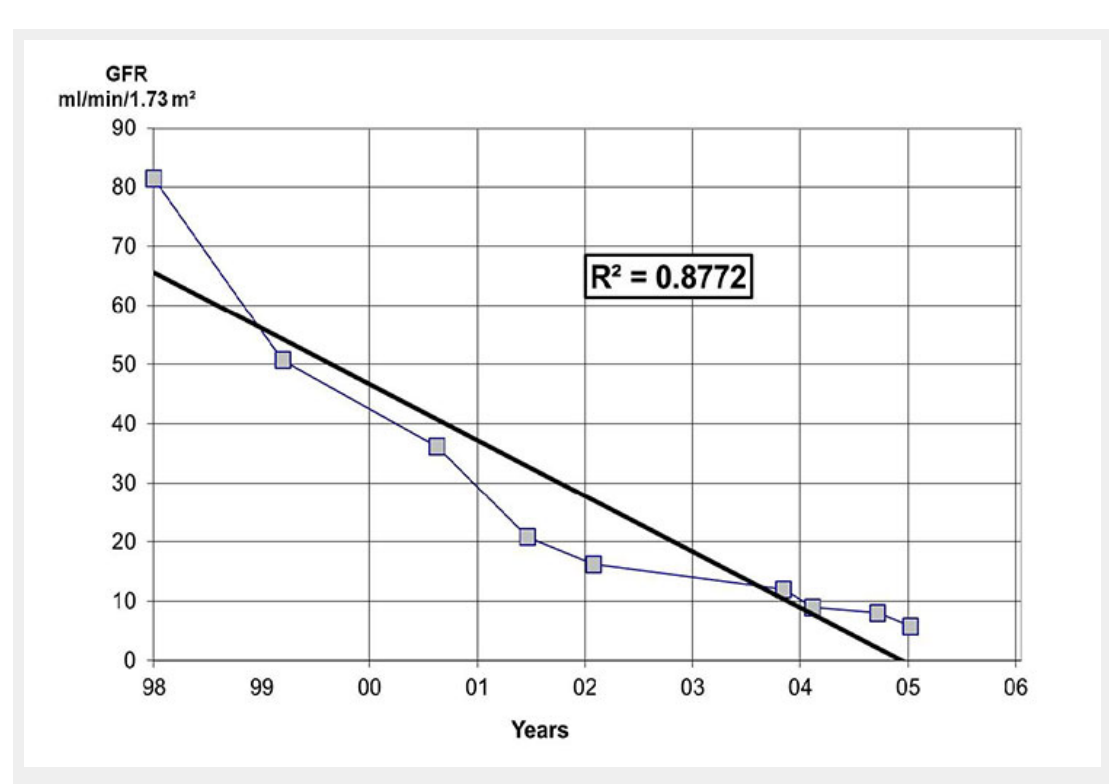
An example from a patient of a graph with the estimated GFR plotted against time. The intersection of the line with a GFR of 10 ml/min/ 1.73m2 roughly denotes the time needed for renal replacement therapy.